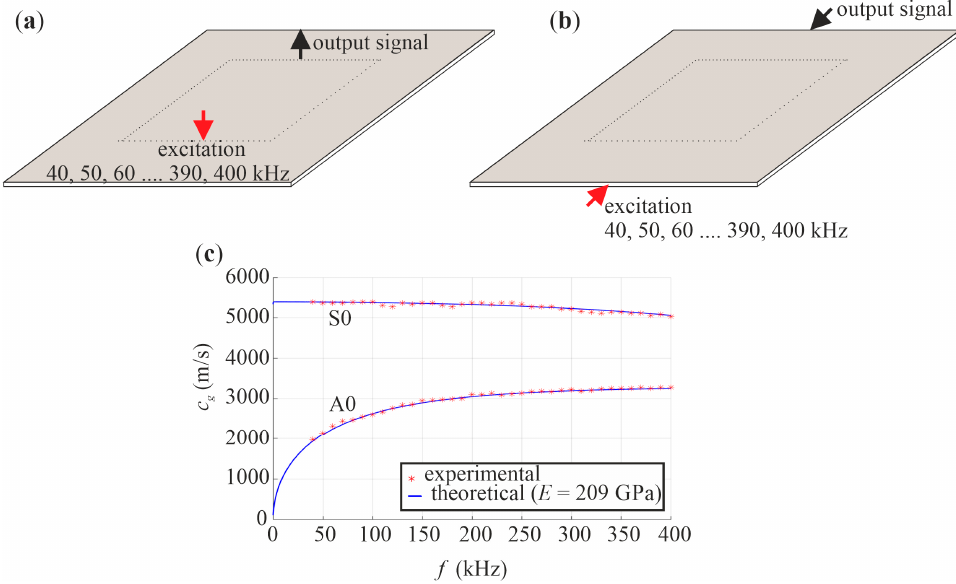
Figure 6. The scheme of experimental tests for determination of dispersion curves for ( a ) A0 mode and ( b ) S0 mode and ( c ) obtained dispersion